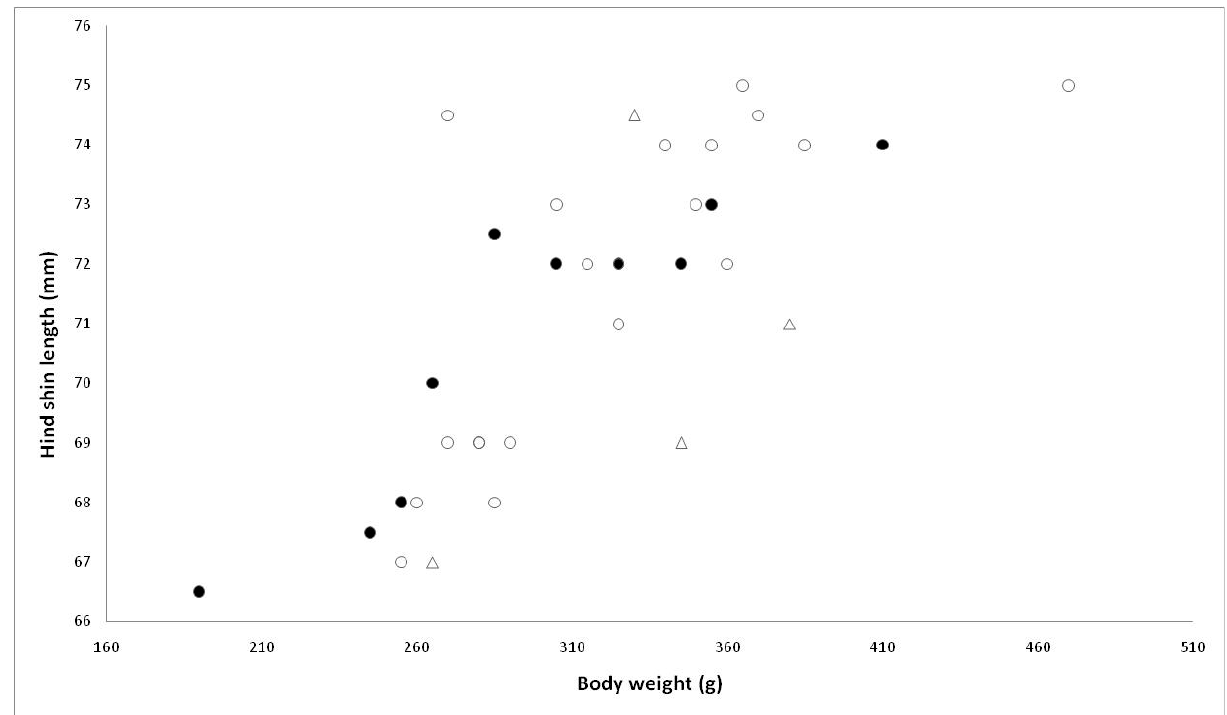
Figure 5. Red squirrel body weight (g) and shin length (mm) during June 2020. Live trapping allowed the partitioning of individual biometrics (weight and shin length) recorded between groups of animals subsequently detected (open triangles) or not found again (open circles). Closed circles—animals trapped in woodland areas that were then inaccessible during October 2020. Open circles—animals trapped in woodland that was later accessible during October 2020 but that were not Scheme 2020. and that were known to be resident there in March 2021 after the autumn/winter squirrelpox outbreak. These encompassed three females and single male.